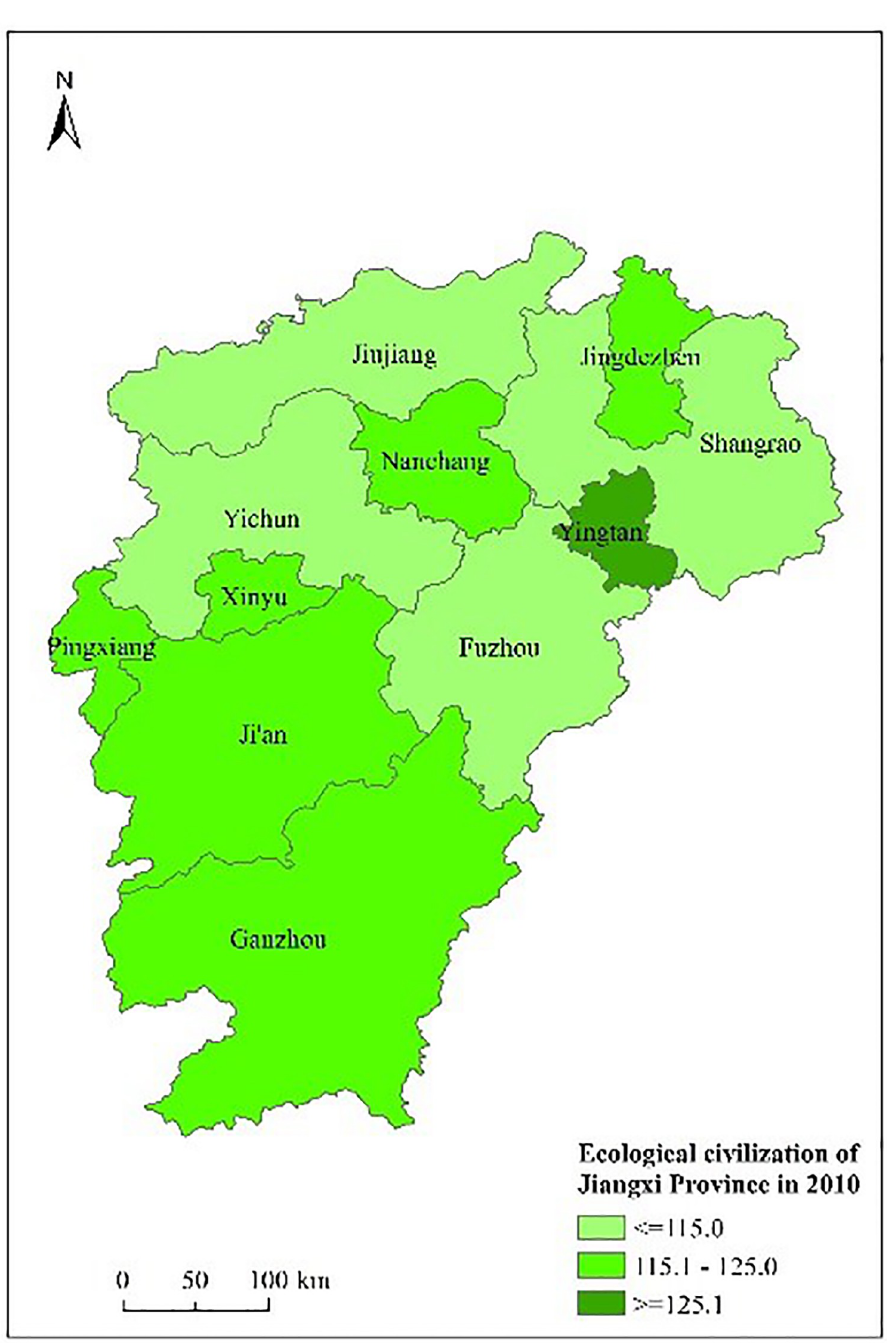
Fig 3. Space distribution of ecological civilization of Jiangxi Province (base map and data from OpenStreetMap and OpenStreetMap foundation. Contains information from OpenStreetMap and OpenStreetMap foundation, which is made available under the Open Database license. Data source comes from Table 4). Source: Republished from Jiangxi Provincial Bureau of Statistics under a CC BY license, with permission from China Statistics Press, original copyright 2010 to